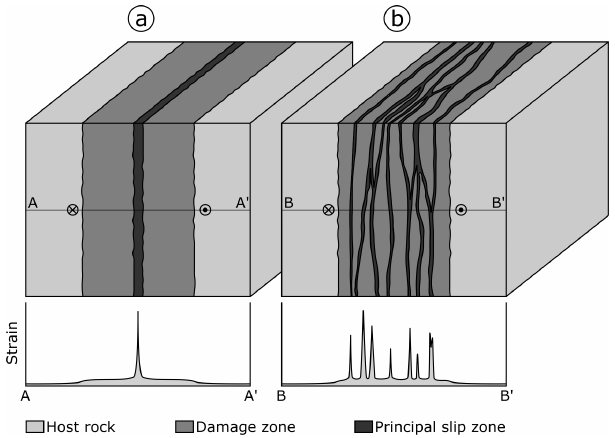
Figure 1. Conceptual end-member models of fault zone architec- ture. (a) According to the model of Caine et al. (1996) a fault is a relatively simple structure, where most of the strain is accommo- dated at a single, quite narrow fault core hosting a principal slip zone. (b) Faults described by the model of Faulkner et al. (2003) are more complex and consist of a damage zone hosting multiple, anastomosing principal slip zones forming a complex